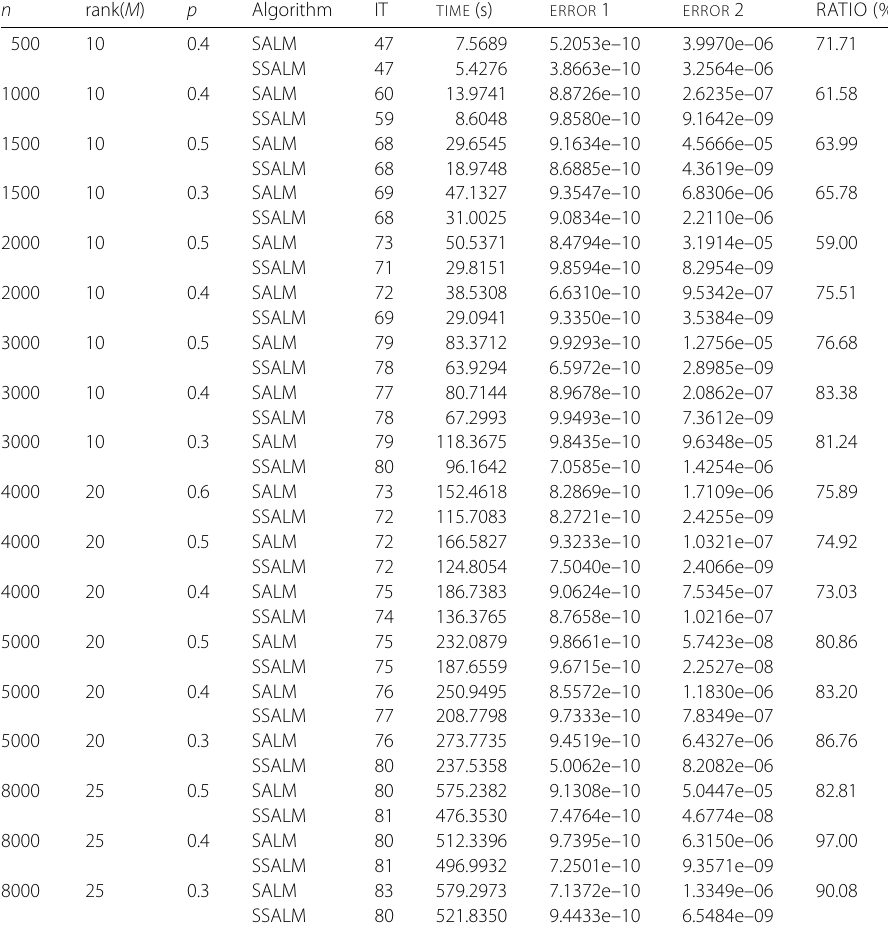
Table 6 Comparison between SALM and SSALM for (cid:11) = 3 n rank( M ) p